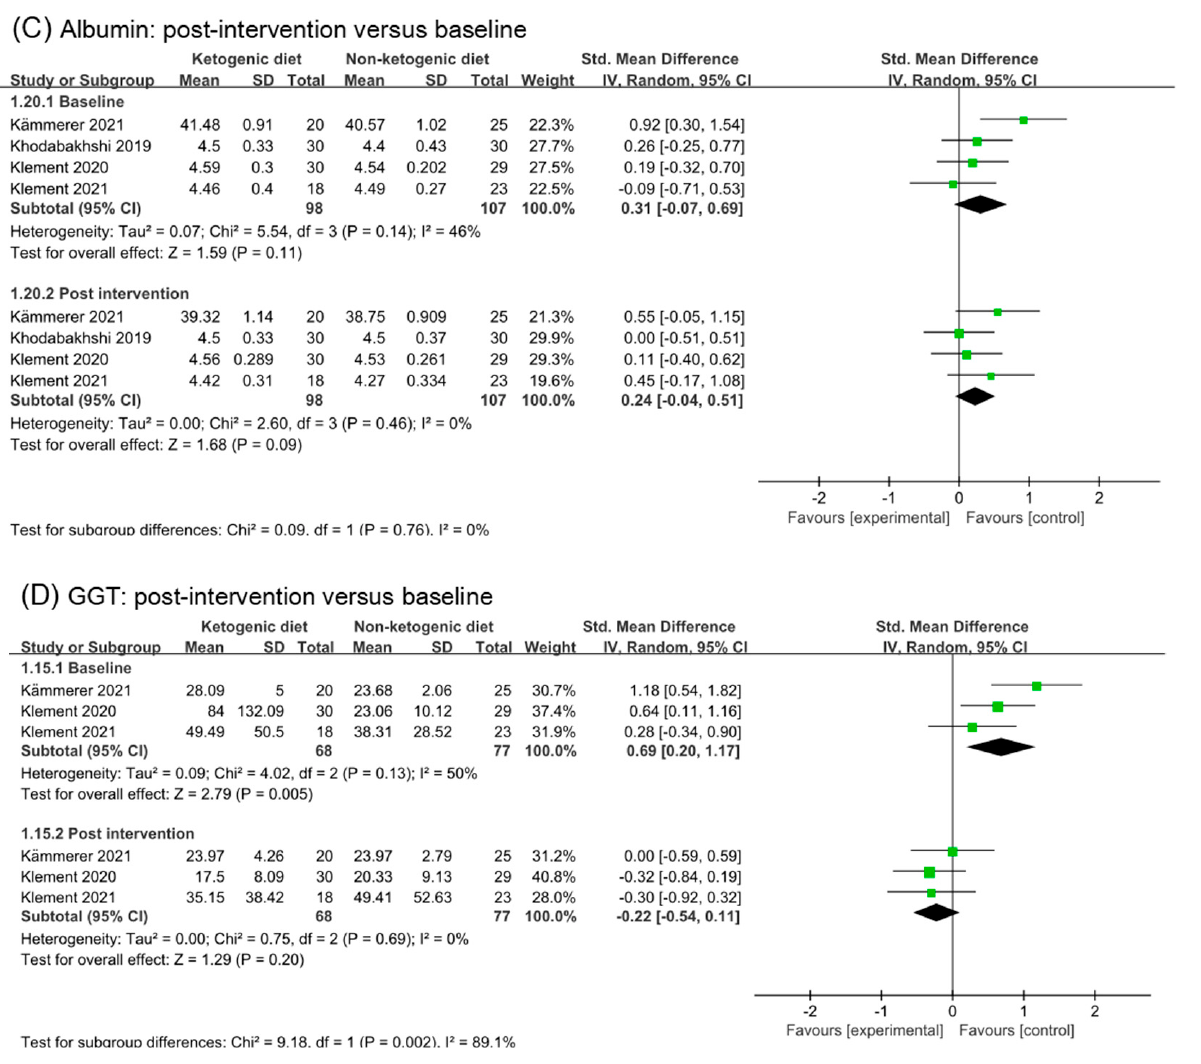
Figure 8. Forest plot for the effects of ketogenic diets on liver function. ( A – D ) were subgroup effects of the baseline versus post-intervention on ALT, AST, albumin, and GGT [31–33,36,37,40–42].